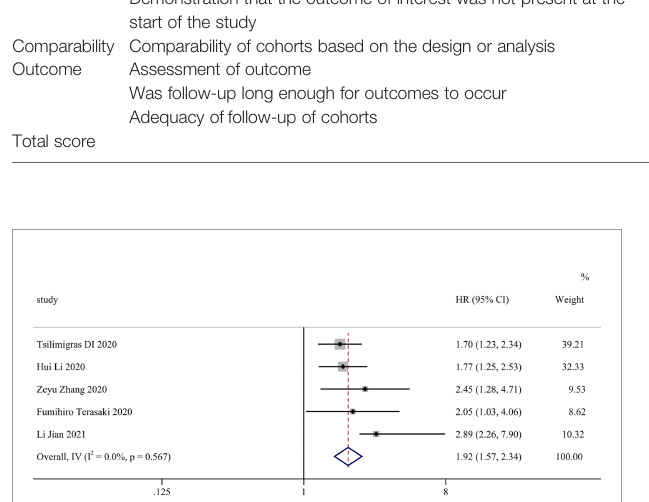
FIGURE 2 | Forest plot of studies evaluating the associations between preoperative SII and OS in cholangiocarcinoma.